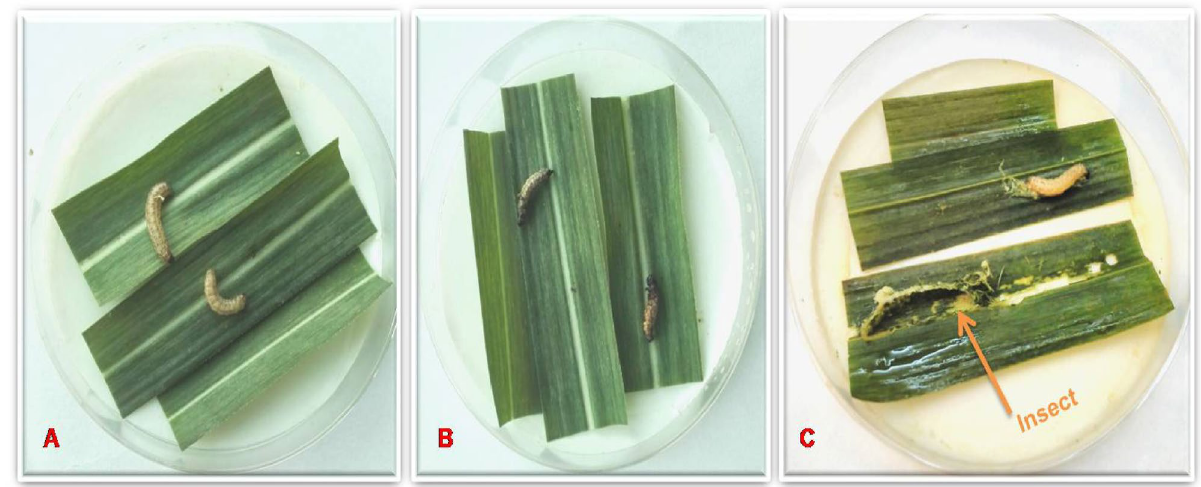
Figure 17. Leaf bioassay of transgenic sugarcane plant leaves and control plants in V 1 -generation. ( A ) Transgenic young leaf with Chilo infuscatellus. ( B ) Dead insects Chilo infuscatellus. ( C ) Control (non-transgenic plants) Chilo infuscatellus alived and